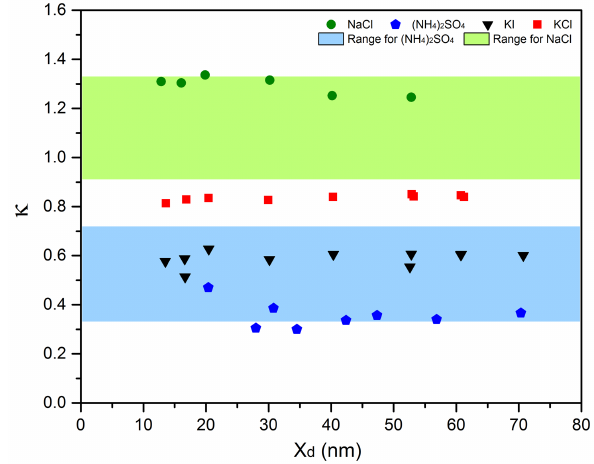
Figure 3. Hygroscopicity parameter ( κ ) as a function of dry particle diameter ( X d ) for NaCl, (NH 4 ) 2 SO 4 , KI, and KCl.